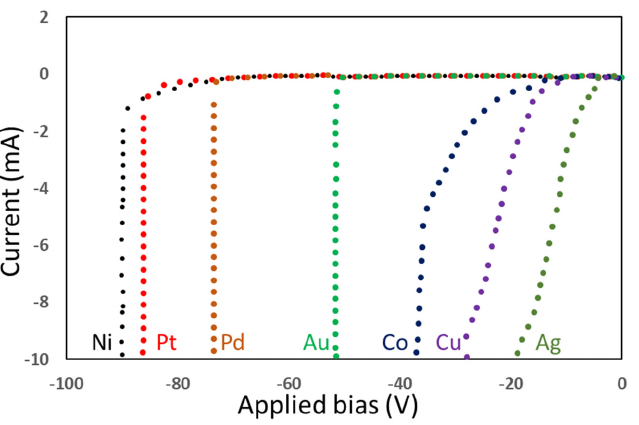
Figure 11. IV characteristic diagram of different metals under reverse bias [68] . (Data from